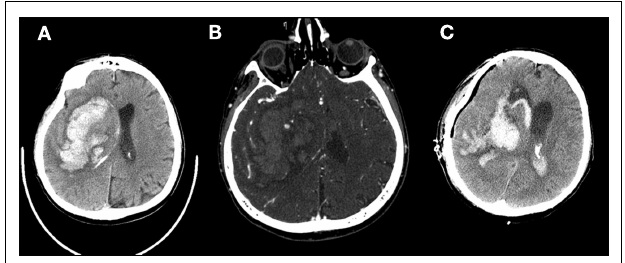
intraparenchymal hemorrhage projected over the basal ganglia with severe mass effect and ipsilateral ventricular hemorrhage. (B) Multiple Spot Signs were present on CTA raw images. (C) Patient underwent emergent craniectomy and hematoma evacuation demonstrated 1day